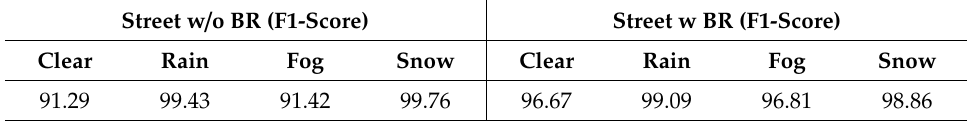
Table10. F1-Scoreperclassforthestreetregionwhenusingtheparameters: n peak , x mean , x σ , n e 2 , EPW mean